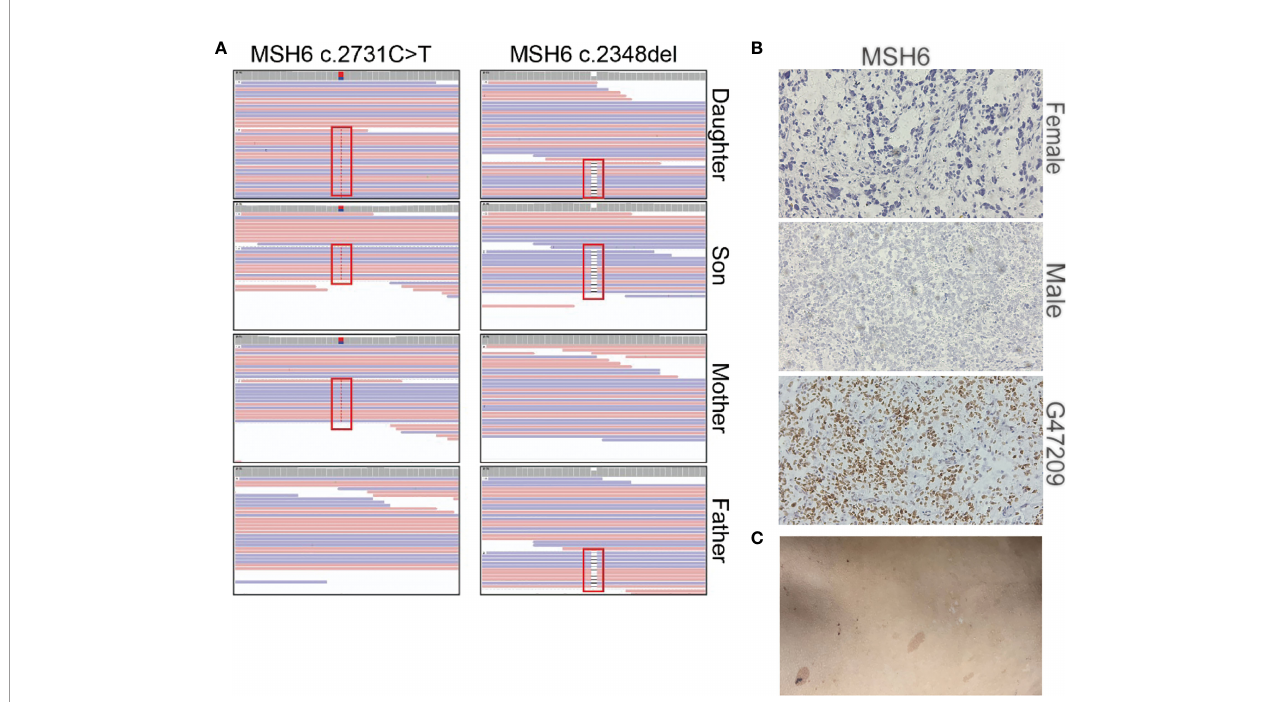
FIGURE 4 | Summary of the MSH6 mutation in the two brain tumor cases. (A) Mutation positions of MSH6 in the two brain tumor cases and their parents. (B) MSH6 staining in the two brain tumor cases and the positive control from a glioma case (G47209) expressing MSH6. The magni fi cation is 20×. (C) Hyperpigmented skin lesions in the male